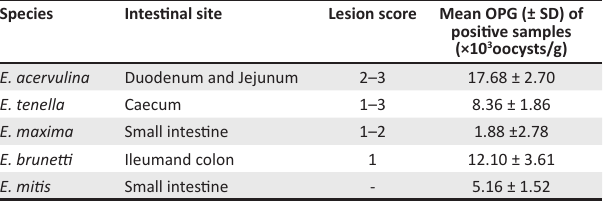
TABLE 2: The mean oocysts per gram, sites and lesion score of Eimeria spp. at broiler chicken farms in Bejaia province. Species Intestinal